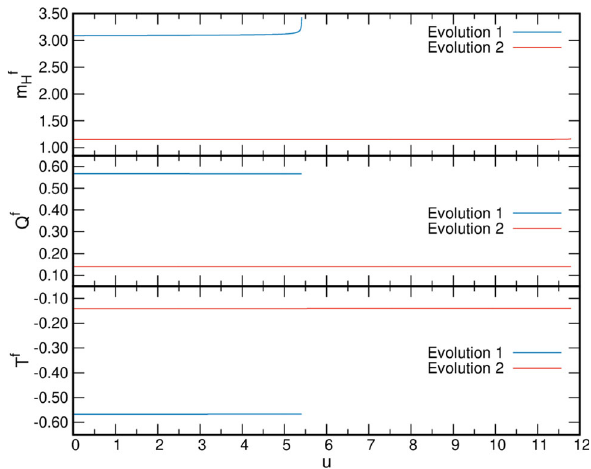
Fig. 21 Hawking masses, m f , and charges related to the U ( 1 ) gauge H fields, Q f and T f , calculated along v = 7 . 5 as functions of retarded time, u , for both tested